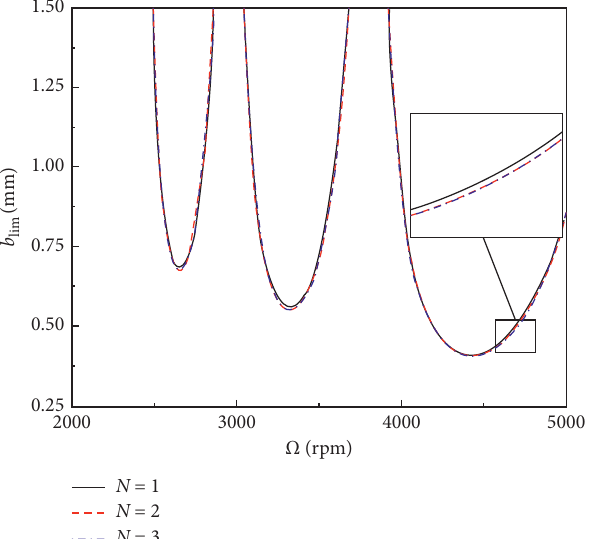
Figure 6: The effect of the numbers of mode shape function on the stability lobes (l/ d � 10, σ � 0.5, θ � 00).